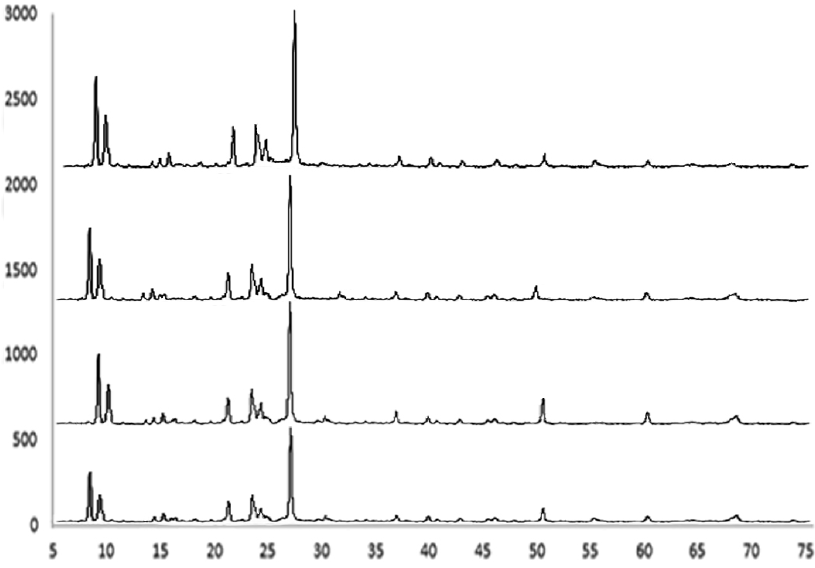
Fig. 4. XRD patterns of Fe-ZSM-5 samples calcined at different temperatures